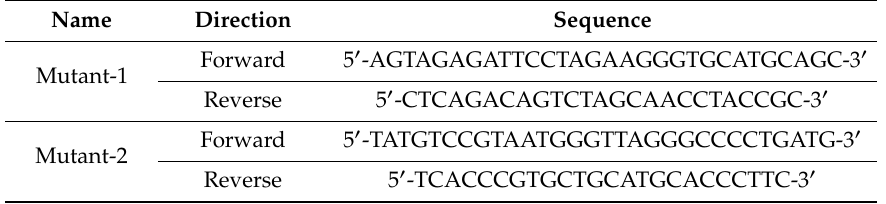
Table 2. Primer pairs for preparation of mutants of kB motif.